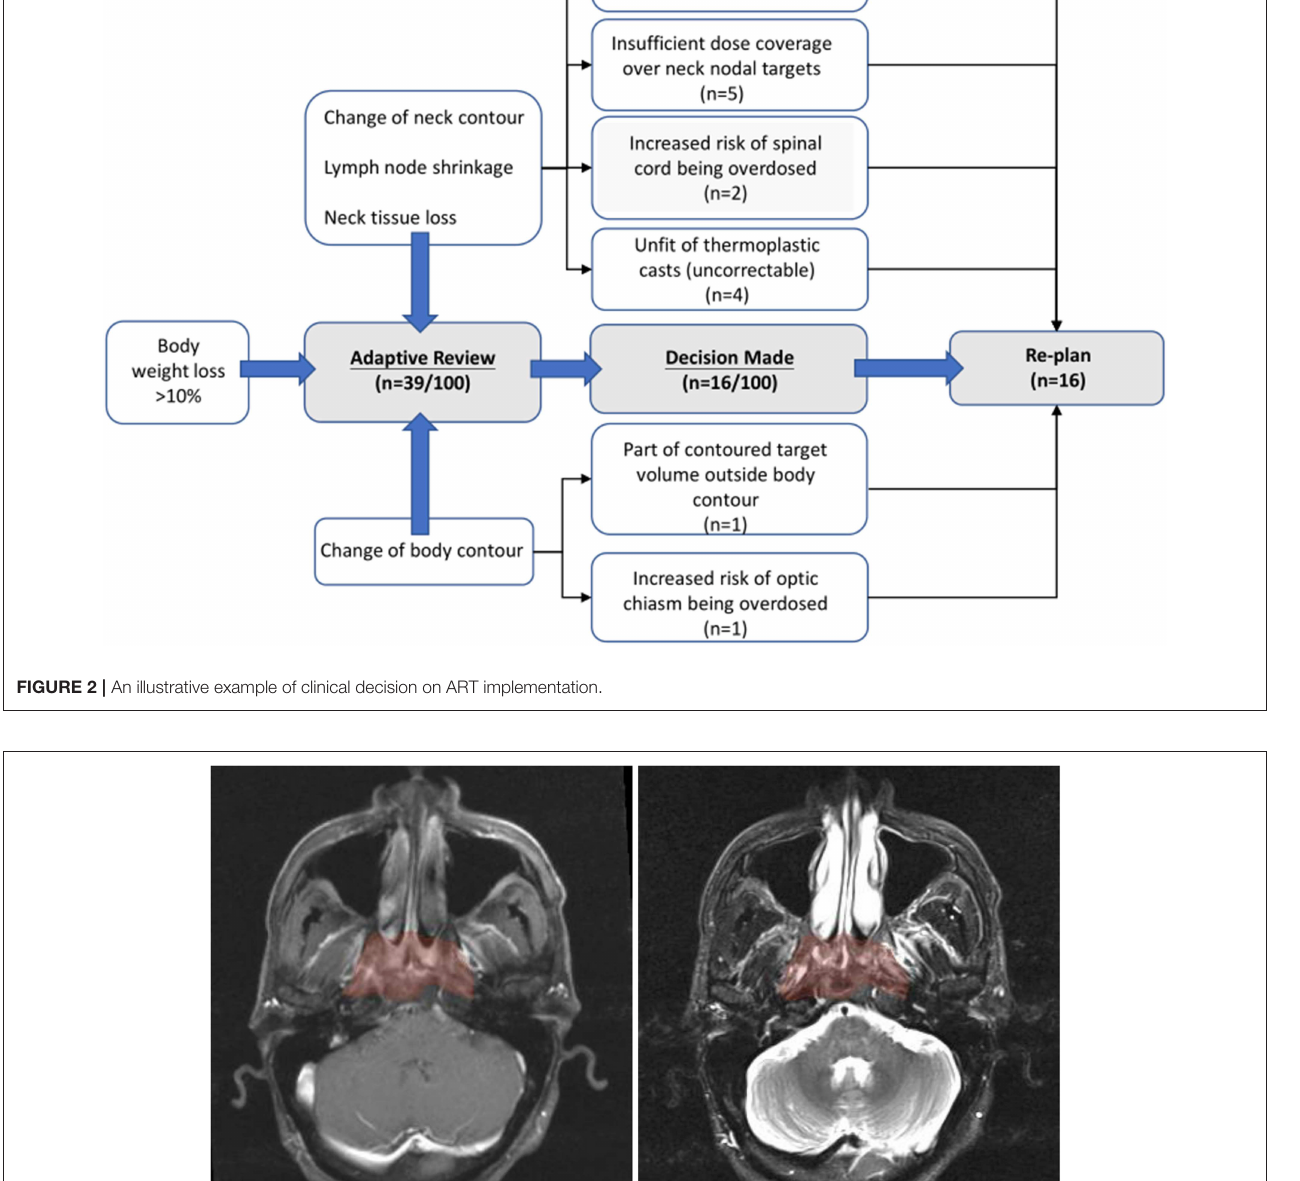
was performed with 20 repetition to determine the optimal value for the model tuning parameter ( λ ). As a result, a total